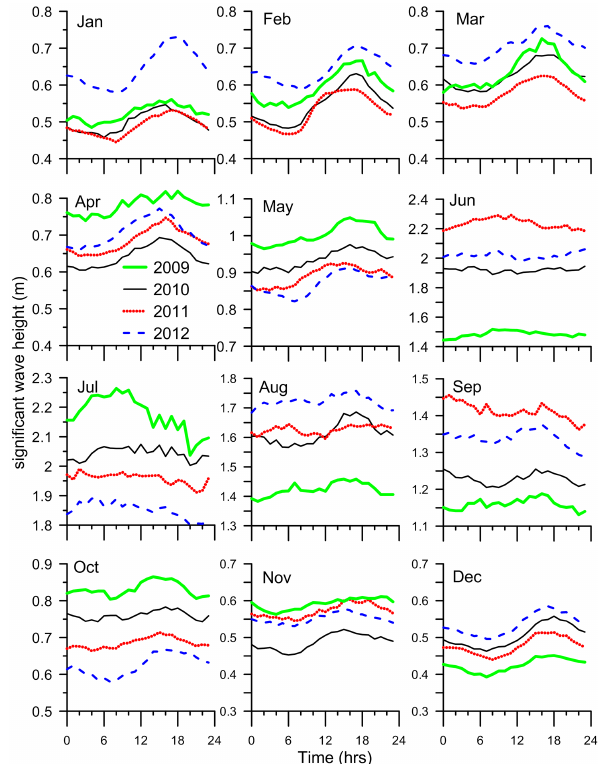
Figure 12. Variation in percentage of short period ( < 6s) waves in half-hourly records averaged monthly with